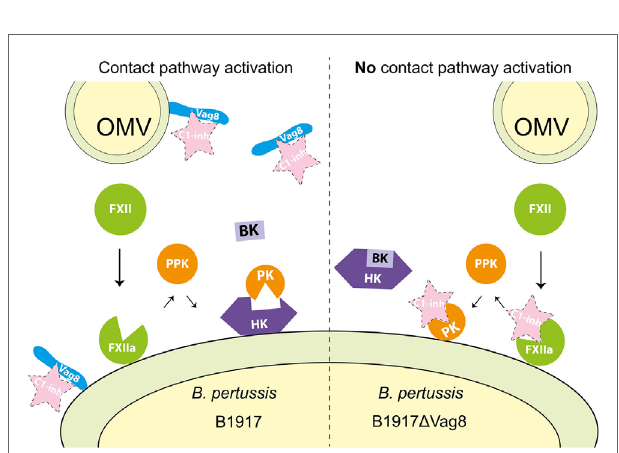
FigUre 6 | Proposed mechanism for Virulence associated gene 8 (Vag8) mediated activation of the contact system. Vag8, either on the bacterial surface as part of an outer membrane vesicles (OMVs) or as the secreted passenger, binds to complement regulator C1 inhibitor (C1-INH) (left panel). This results in the lack of inhibition of the contact system proteases FXIIa and plasma kallikrein (PK) by C1-INH. The lipooligosaccharide and polyphosphates present on the outer membrane of Bordetella pertussis are most likely responsible for FXII activation on the bacterial membrane as has been shown for other bacteria (15, 36–42). This activation, which cannot be inhibited by C1-INH as it is bound to Vag8, will result in the release of bradykinin (BK). In the absence of Vag8, C1-INH will inhibit FXIIa and PK when formed and high-molecular-weight-kininogen (HK) will remain intact away from the bacterial surface (right panel).